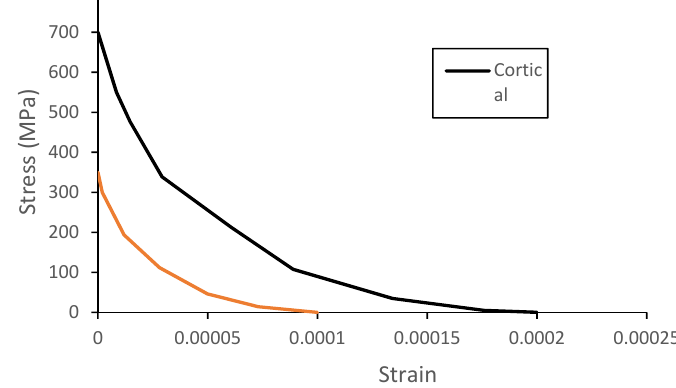
Figure 5. Post-failure stress–strain curve for both cortical and sutures tissues.